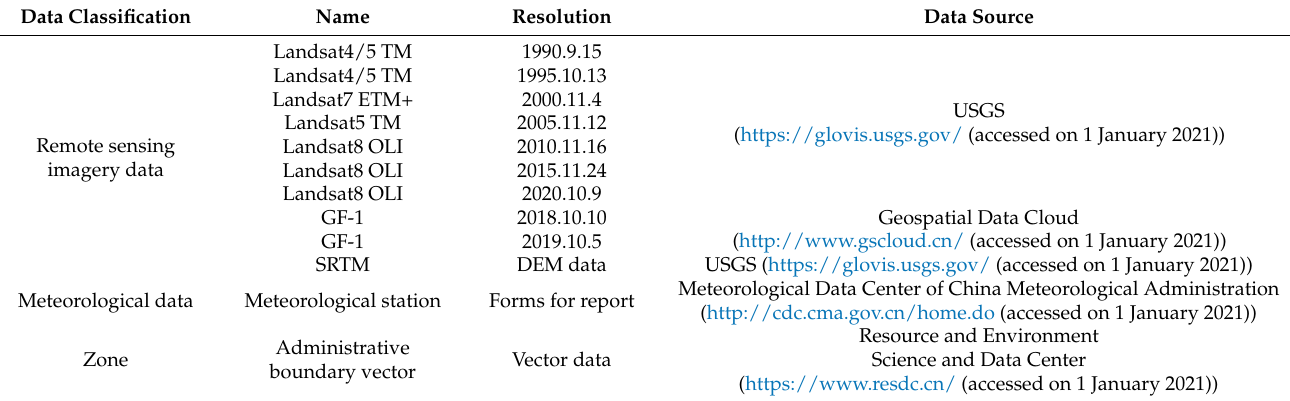
Table 1. Data of the study area.